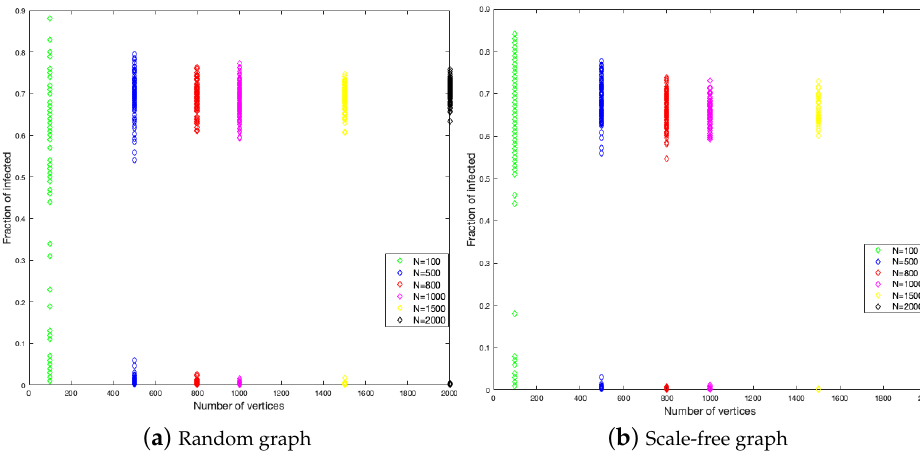
Figure 5. Fraction infected in random and scale-free